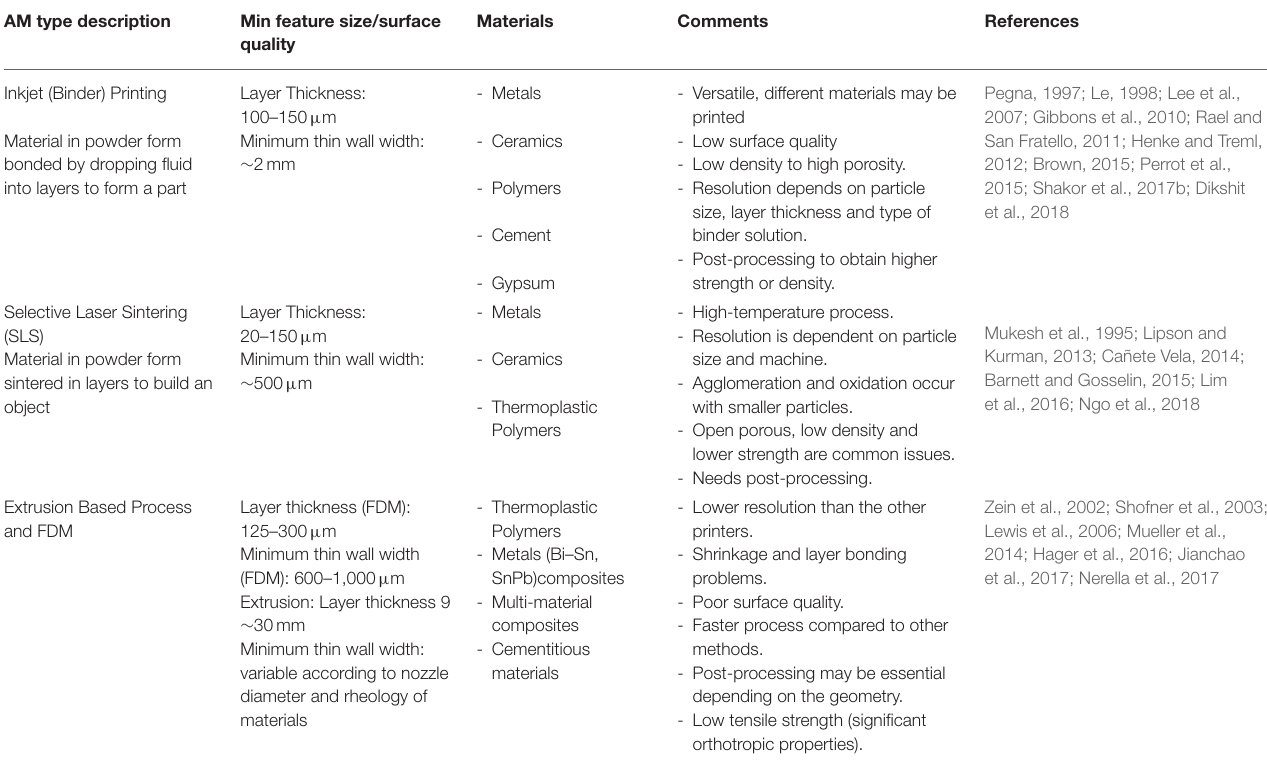
TABLE 2 | Comparison of additive manufacturing technologies in the construction